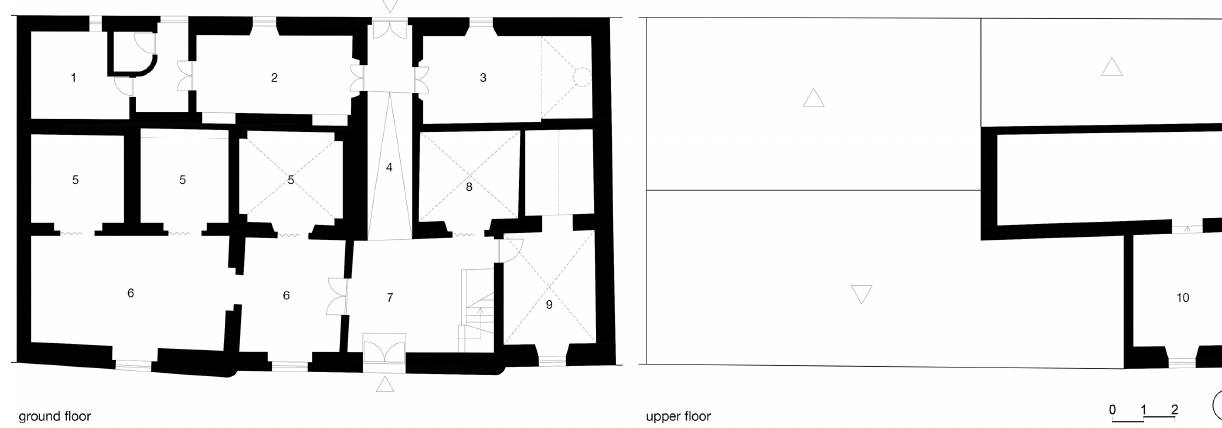
Figure 6. ( a ) External view; ( b ) indoor corridor; ( c ) ventilation window.